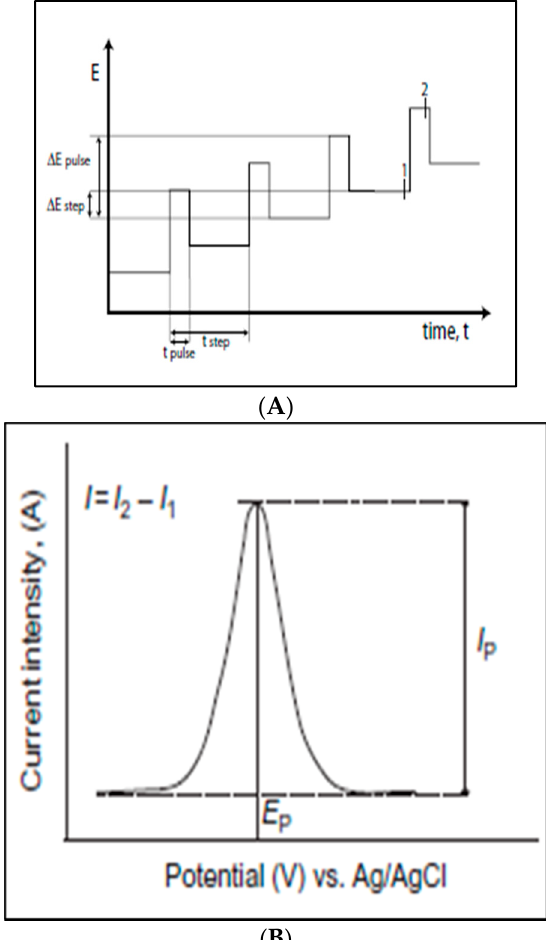
Figure 5. Differential pulse voltammetry showing ( A ) Potential against time; and ( B ) Current against potential (Adapted from [104] copyright Elsevier, 2017).